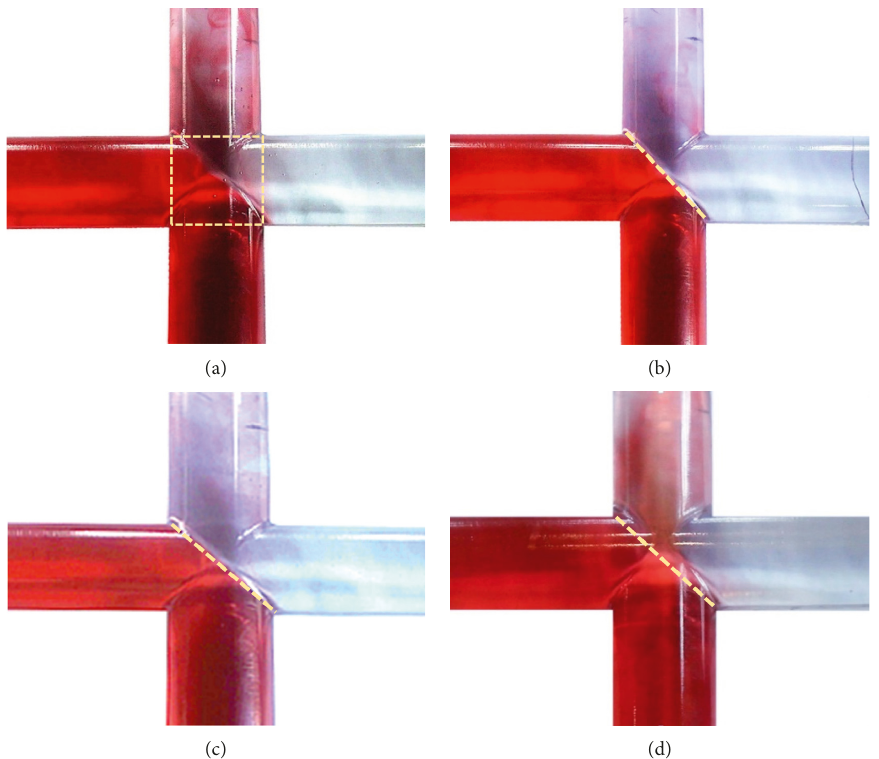
Figure 5: Junction mixing pictures under varied average Reynolds number. (a) Re � 3000. (d) Re ave